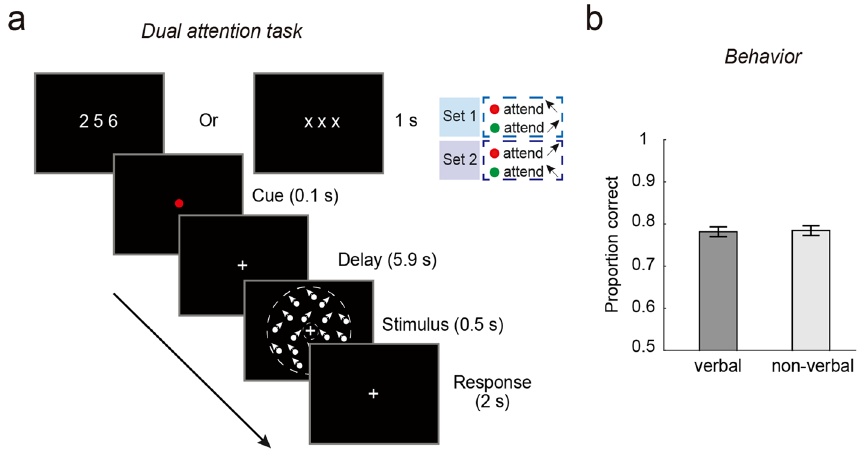
Figure 5. ( a ) Schematic of the articulatory suppression task in the control experiment. The task structure was similar to that in the main experiment (c.f., Fig. 1). At the beginning of each trial, either three digits or “xxx” were shown, indicating whether participants need to read out the digits or not, respectively. ( b ) Task performance, as indexed by the proportion of correct trials. Error bars are within-subject